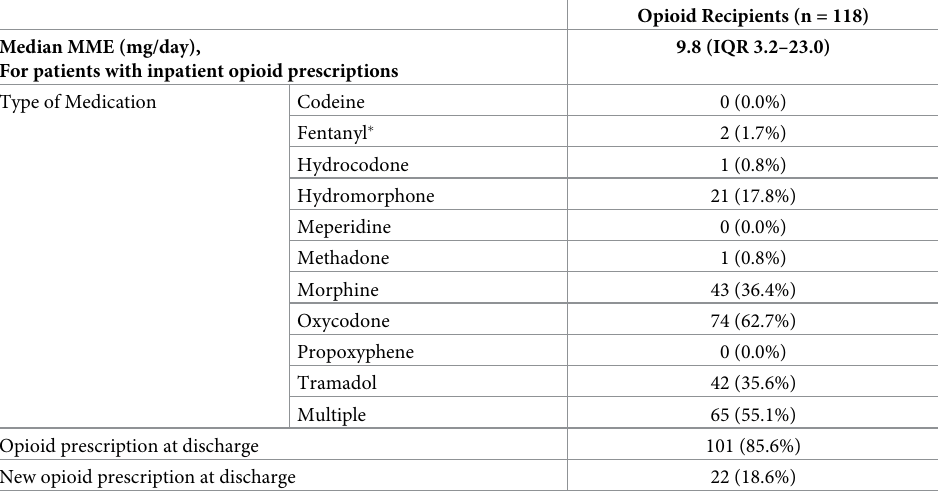
Table 5. Characteristics of opioid use during hospitalization.